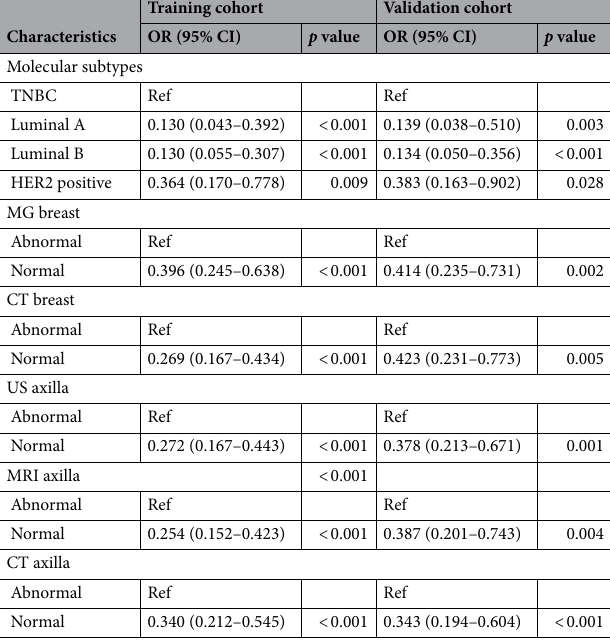
Table 2. Multivariate logistic regression analysis.